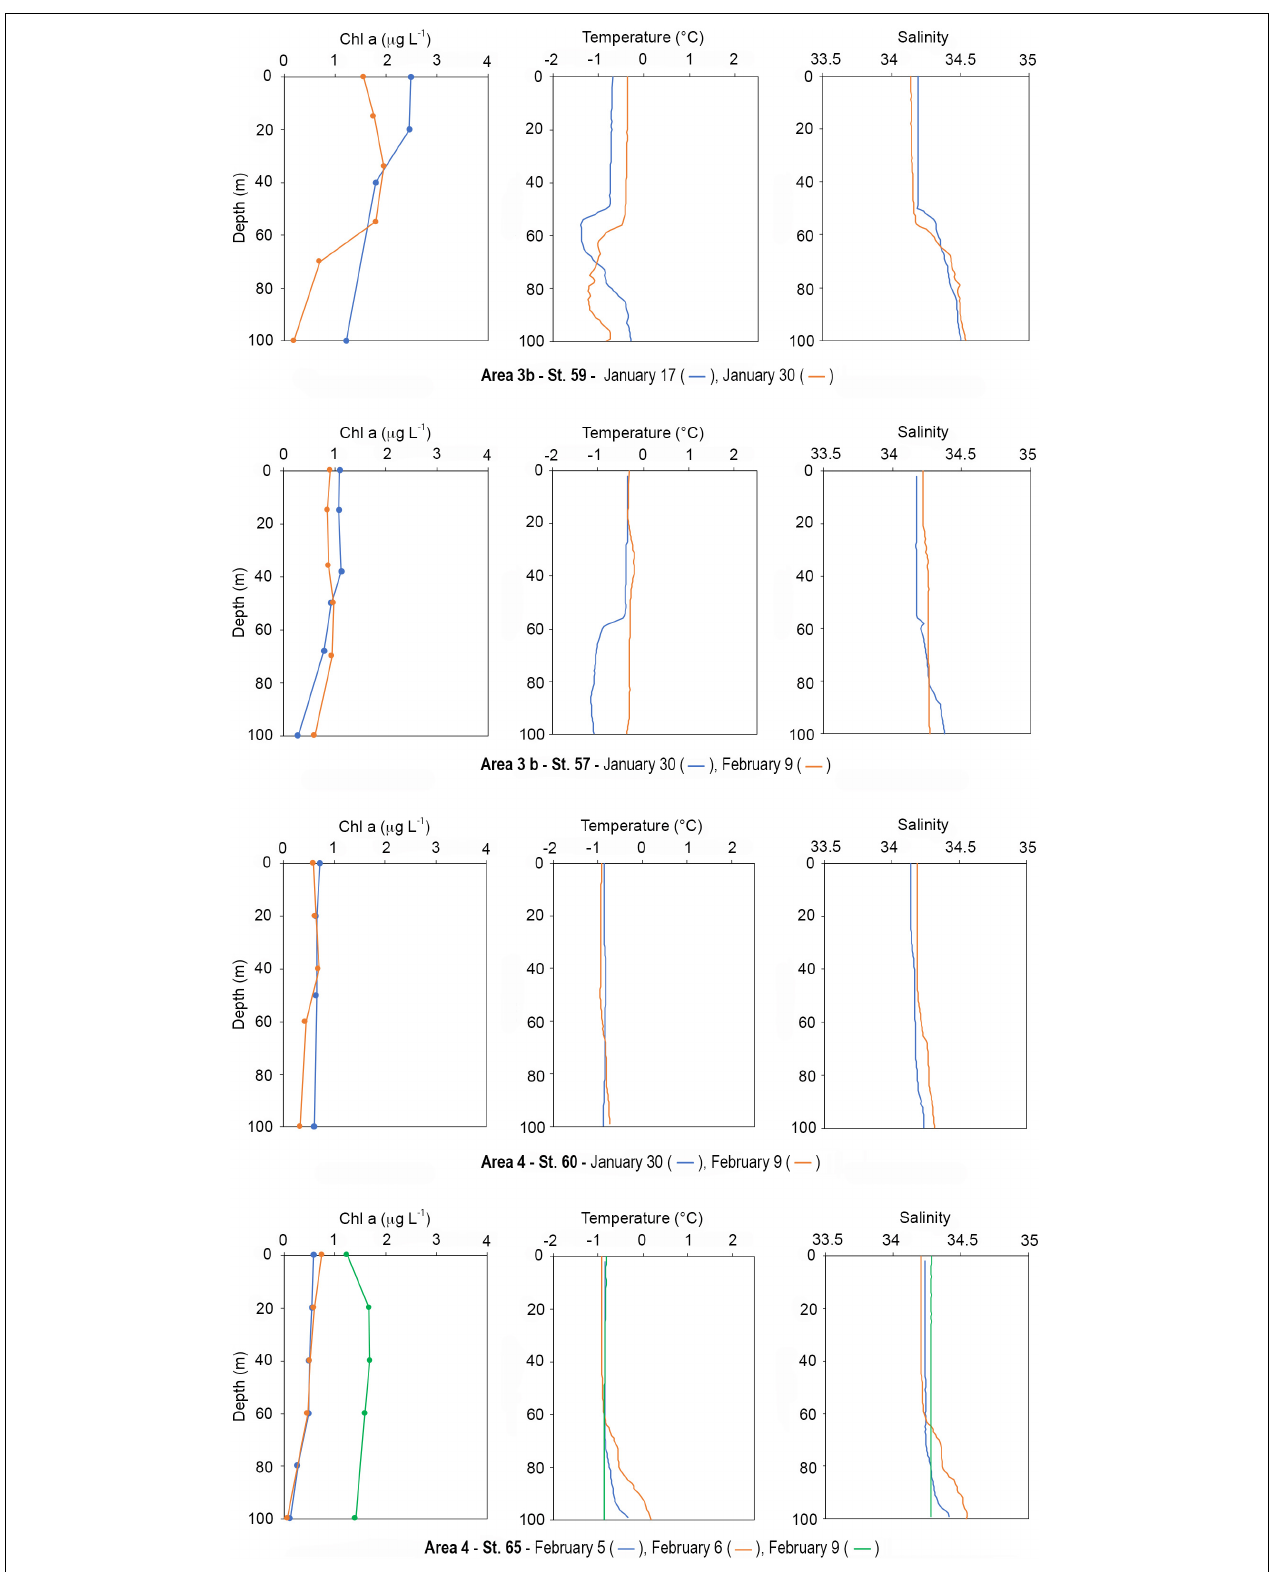
FIGURE 11 | Vertical profiles of chl a ( µ g L − 1 ), temperature, and salinity at resampled stations in Area 3b, stations 57 and 59, and in Area 4, stations 60 and 65.